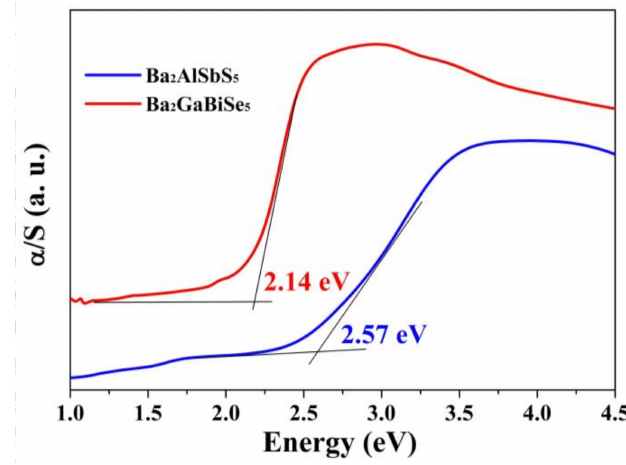
Figure 5. Experimental bandgaps of title